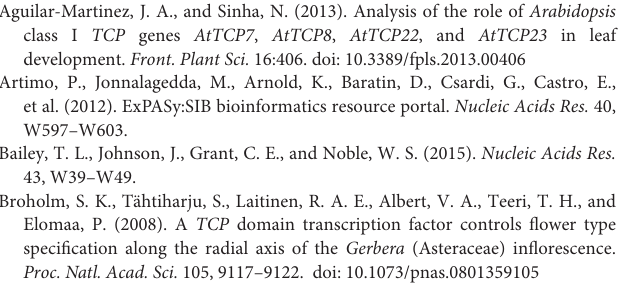
Supplementary Table 7 | All TCP gene promoter sequences